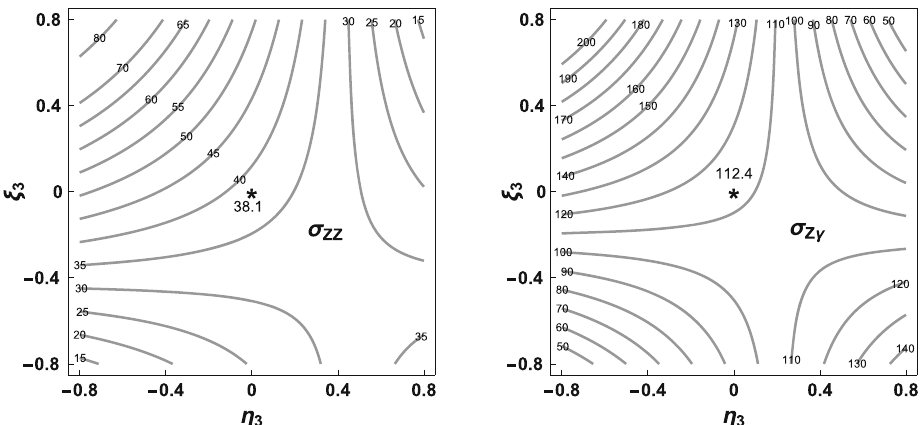
Fig. 2 The SM cross section (in fb) for the process e + e − → Z Z / Z γ as a function of longitudinal beam polarizations η 3 (for e − ) and ξ 3 (for e + ) √ s = 500 at